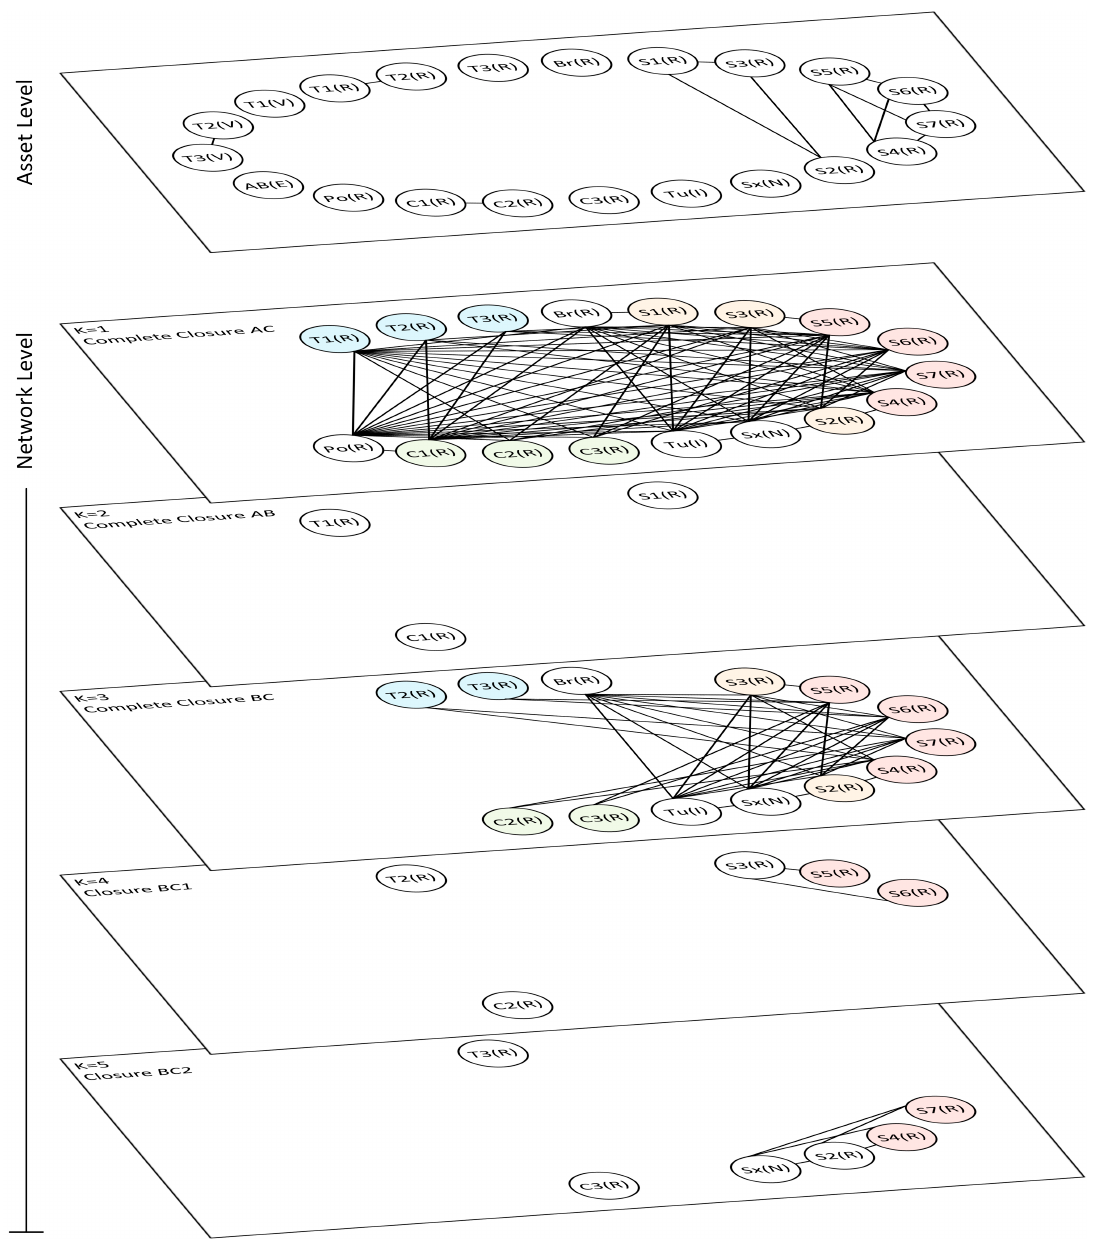
Figure 6. Network level